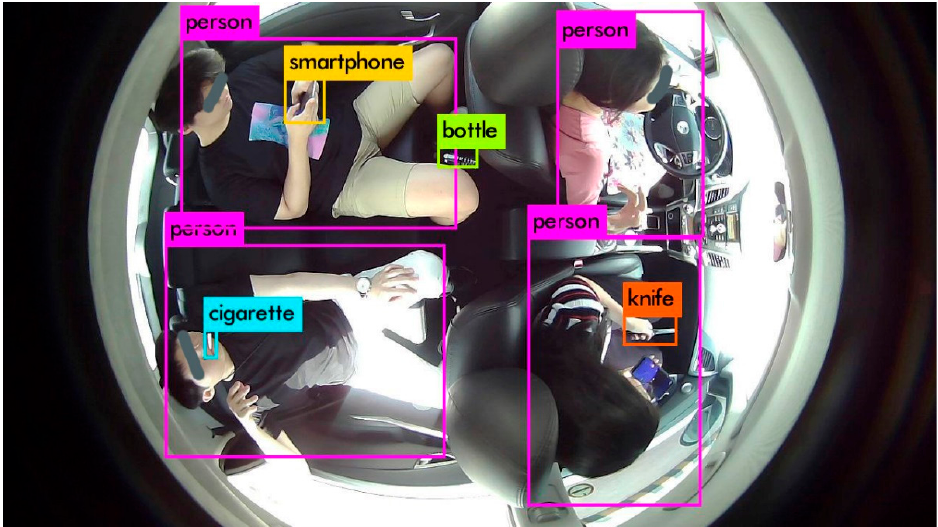
Figure 16. An illustration of in-cabin monitoring using the proposed IMS.